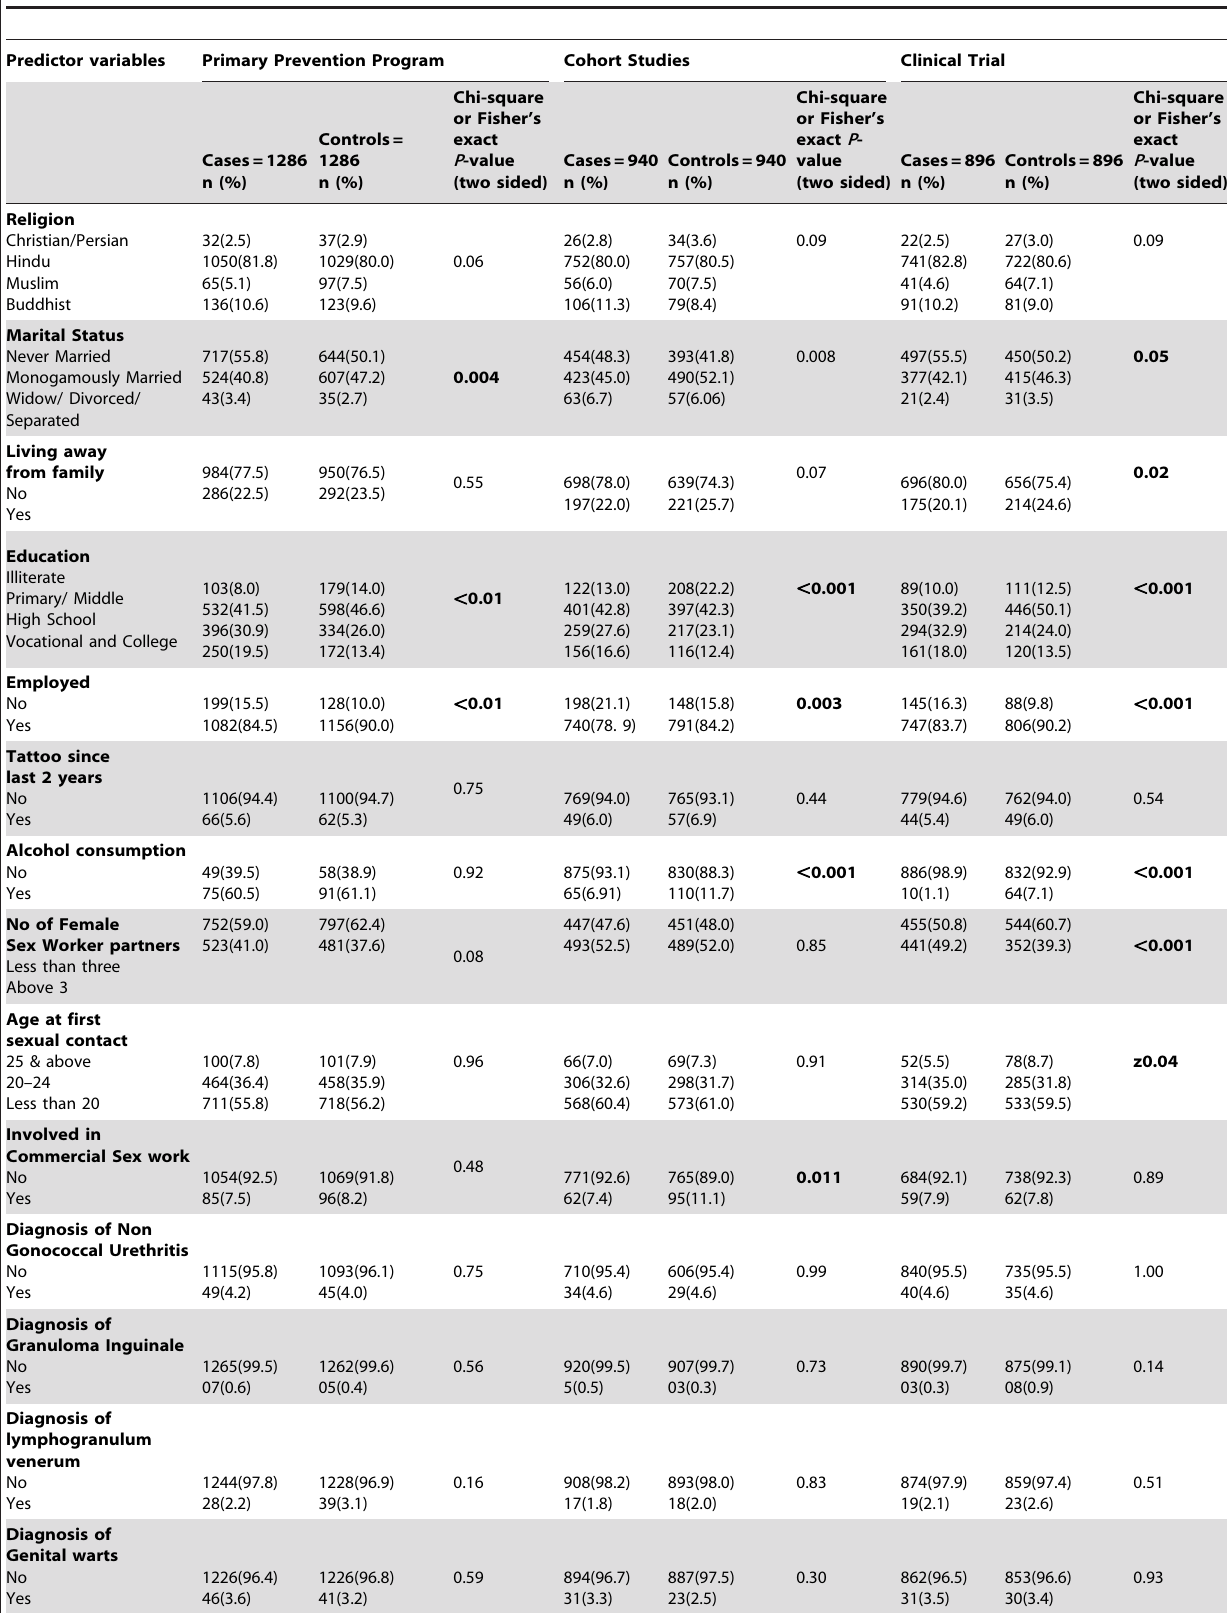
Table 1. Profile of men identified as cases and controls in three respective scenarios of primary prevention, cohort study and clinical